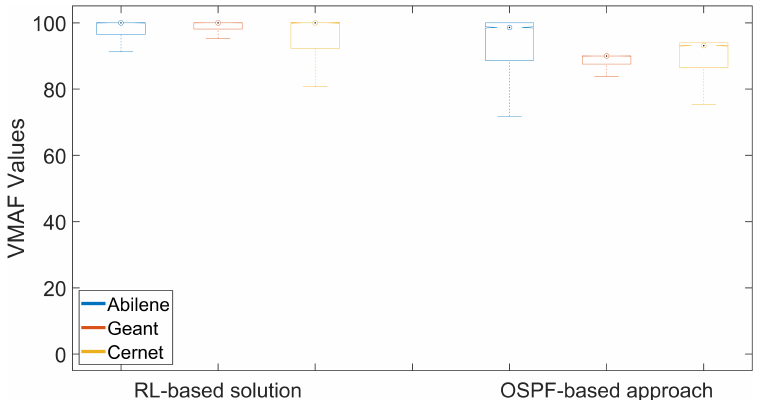
Figure 5. VMAF values for DASH video under low traffic loads in three different